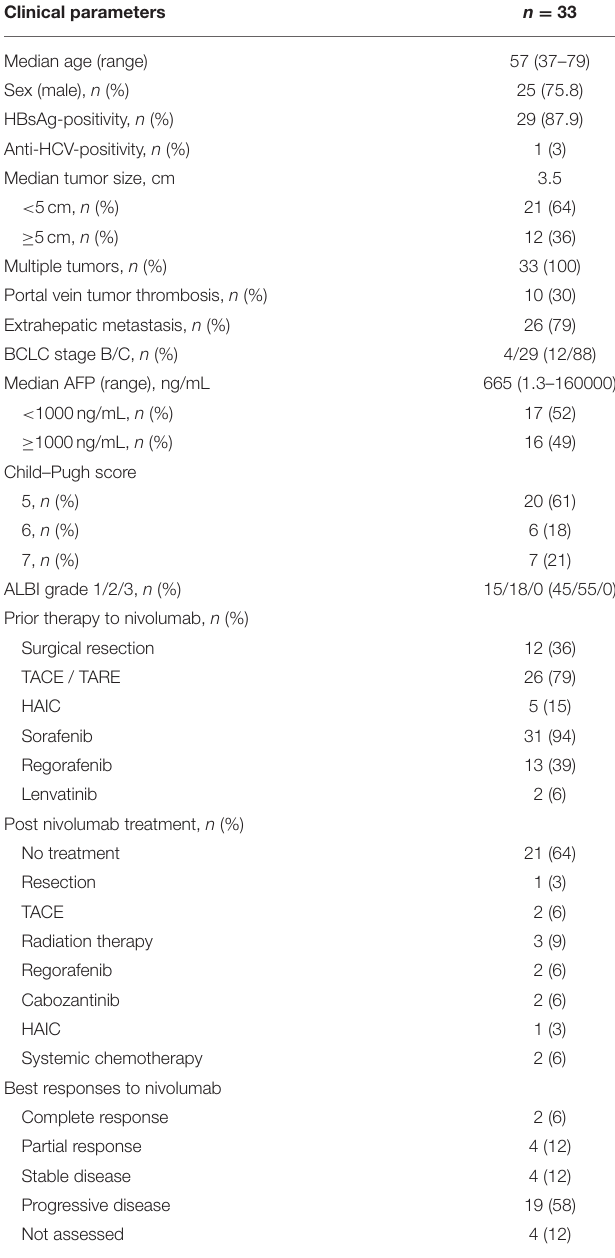
TABLE 1 | Clinical parameters of study patients. Clinical